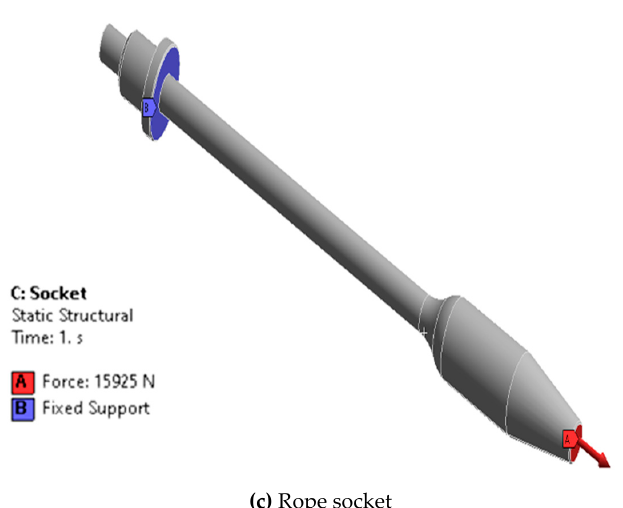
Figure 6. Boundary conditions for the structural analysis.